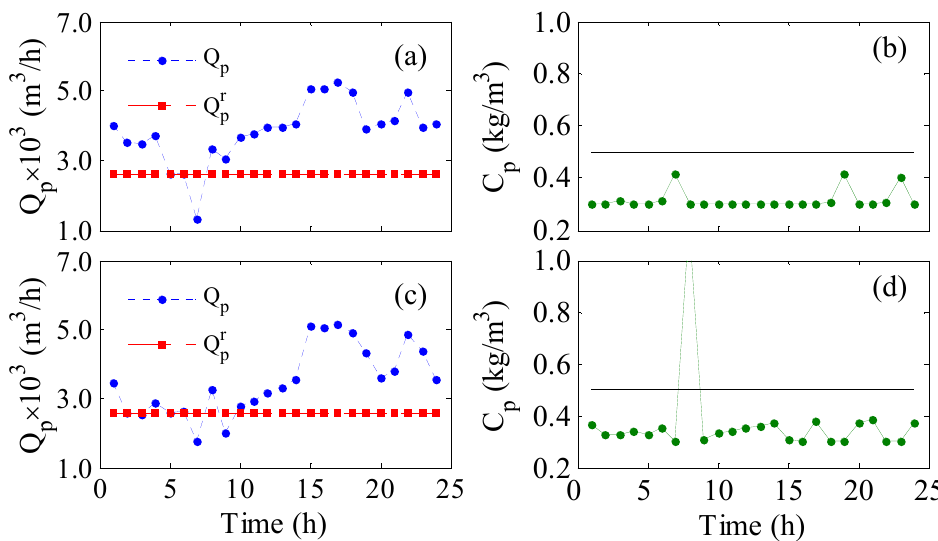
Figure 4. Instantaneous control results for bounded LP ( a , b ) and unbounded LPb ( c , d ).